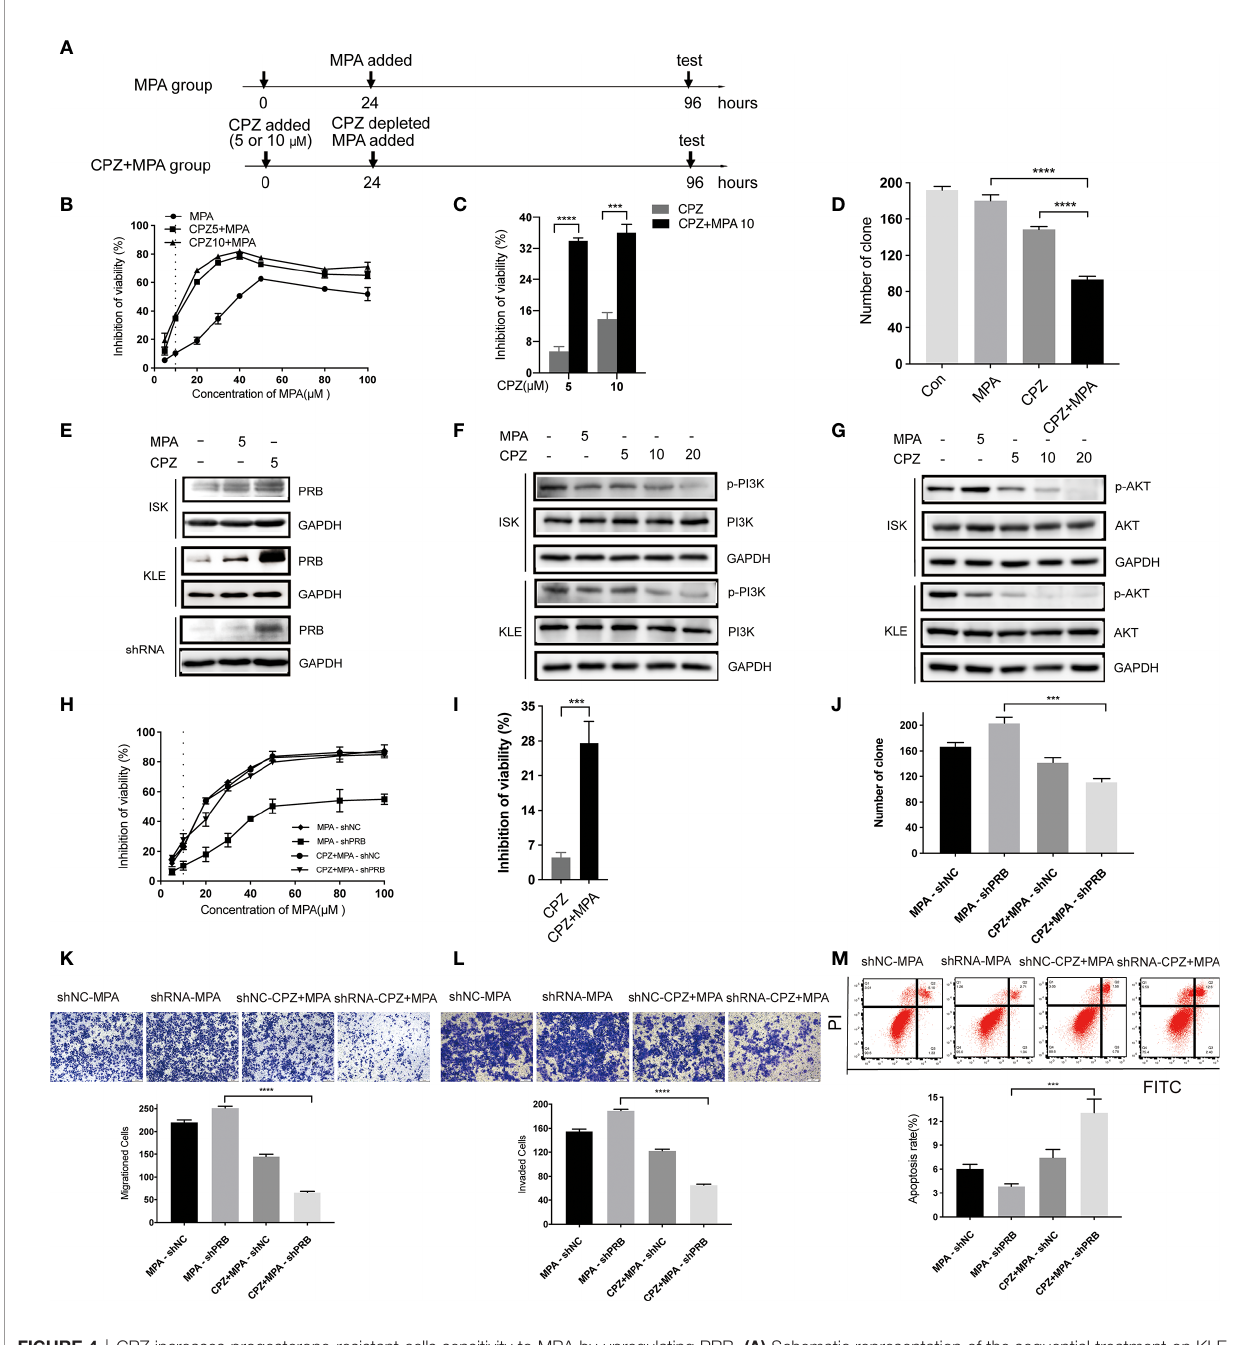
FIGURE 4 | CPZ increases progesterone-resistant cells sensitivity to MPA by upregulating PRB. (A) Schematic representation of the sequential treatment on KLE and shRNA cells. Cells were divided into two groups: MPA group (cultured for 24h, MPA added, cultured for 72h, then test) and CPZ + MPA group (CPZ added, cultured for 24h, CPZ depleted, MPA added, cultured for 72h, then test). (B, C) After 24 h exposure to CPZ of 5 m M and 10 m M, cells were administered with various concentrations of MPA; cells were then analyzed by a Coulter Counter 72 h later. (D) Pre-treatment with CPZ before MPA treatment decreases the colony formation of KLE cells as compared to MPA or CPZ treatment alone. Cells were pre-treated with CPZ for 24 h before MPA treatment for 72 h. (E) CPZ upregulated the protein level of PRB in KLE and shRNA cells treated with 5 m M CPZ for 24h. (F) Effect of CPZ on PI3K activity was assayed by immunoblotting for total PI3K and phosphorylated PI3K Tyr467/Tyr199 . (G) Expression levels of AKT and p-AKT ser473 in ISK and KLE cell lines when treated with CPZ. (H, I) Pre-treatment with CPZ for 24h, shRNA cells were incubated with MPA at various concentrations for 72 h. (J) CPZ decreased MPA-induced colony formation in transfected ISK cells. (K, L) Migration and invasion were observed in transfected ISK cells. (M) Pre-treatment with CPZ, the apoptosis rate of transfected ISK cells in response to MPA. Results are presented as mean ± standard error of the mean and error bars represent the SD of three independent experiments. ***p < 0.001; ****p <